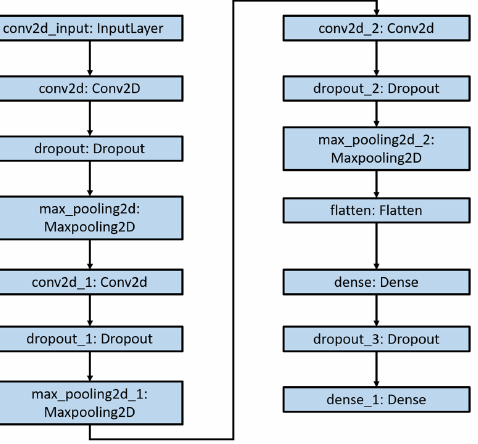
Figure 6. Basic CNN Model Structure for Image Classification.